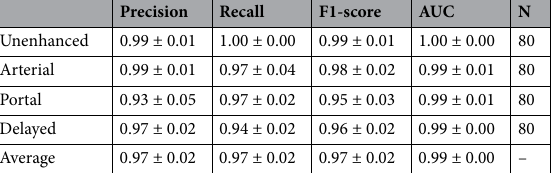
Precision Recall F1-score AUC N Unenhanced Arterial Portal